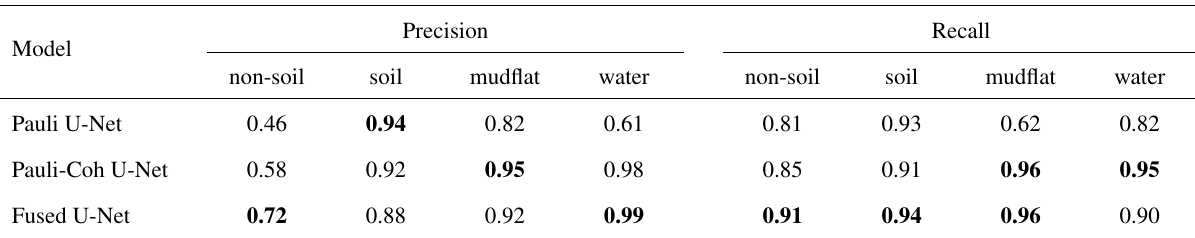
Table 1. Class-wise recall and precision rates for classification of test data achieved by the Pauli U-Net, Pauli-Coh U-Net and Fused U-Net. The best results are marked in bold.